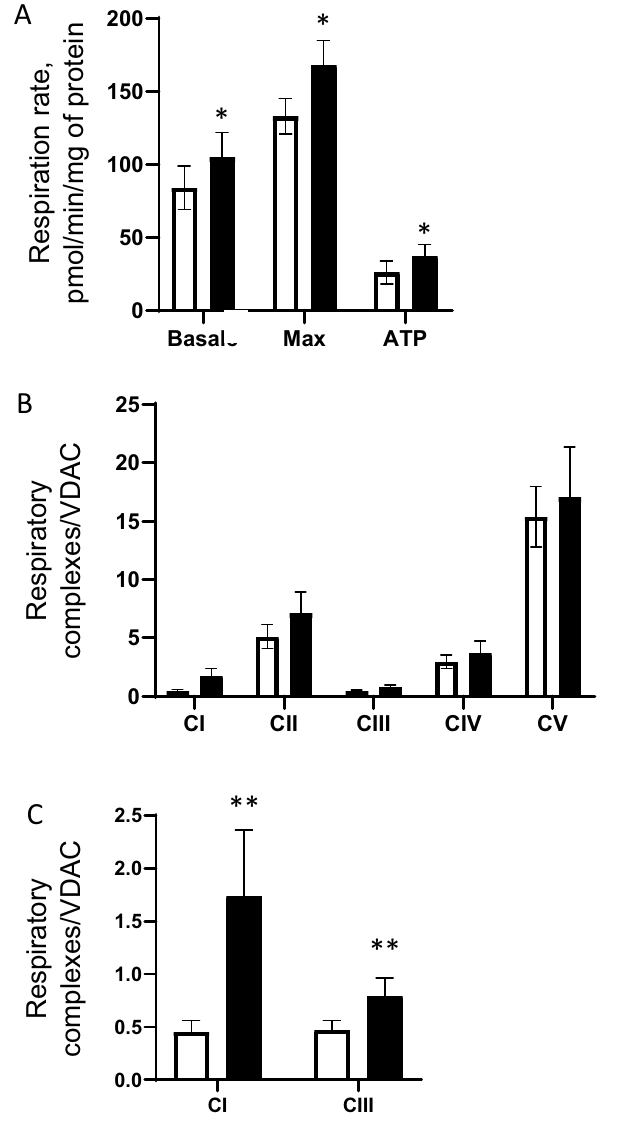
Figure 5. Aerobic metabolism of RHE-KiPS after treatment with plant extract. ( A ) Seahorse analysis of metabolic features of RHE-KiPS at day 13. RHE-control (white bars) or treated with 1% Jasminum Officinale Flower extract & Palmaria Palmata extract, 1% hydrolyzed soy protein extracts (black bars). Statistical significance was determined by Student’s t -test, (mean ± sem; n = 3) ** P < 0.01 and * P < 0.05, errors bars: SEM. ( B ) Quantification of mitochondrial complexes by WES analysis of respiratory complexes. ( C ) Quantification of mitochondrial complexes I and III. Statistical significance was determined by a Student’s t test. ** P < 0.01, errors bars: